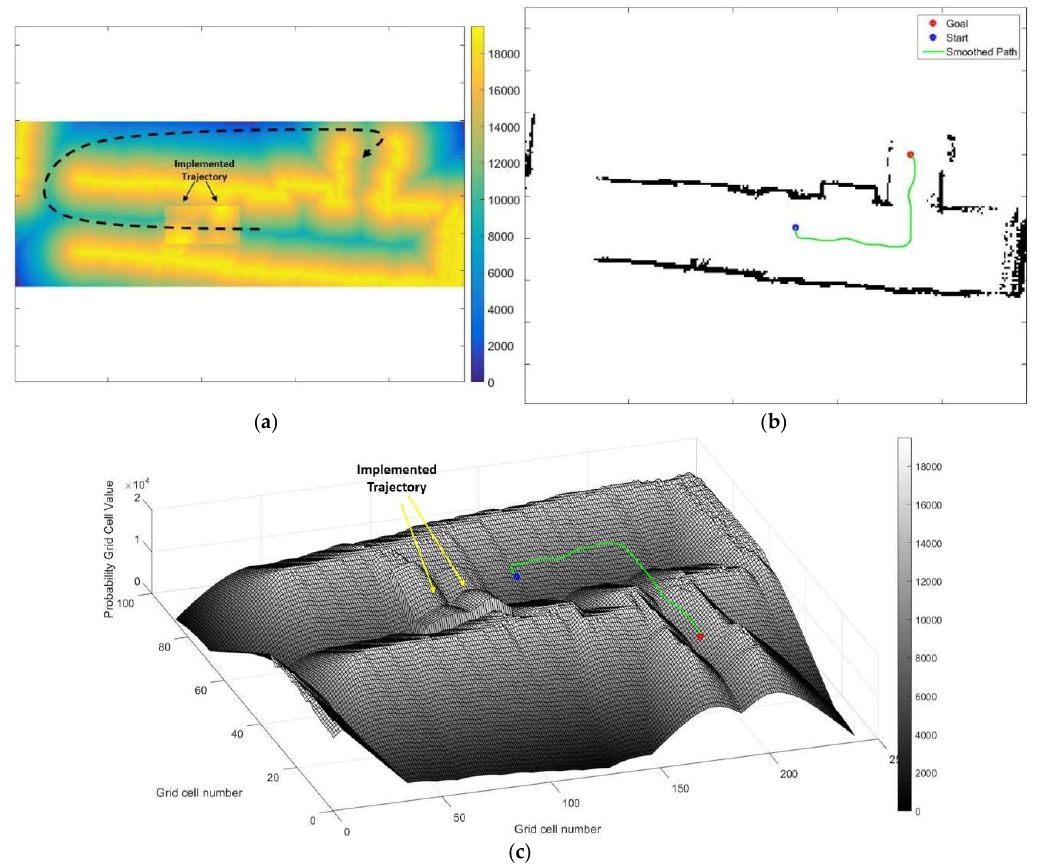
Figure 22. Adjusted A* algorithm in a static environment: ( a ) cost map; ( b ) 2D representation; and ( c ) 3D representation.